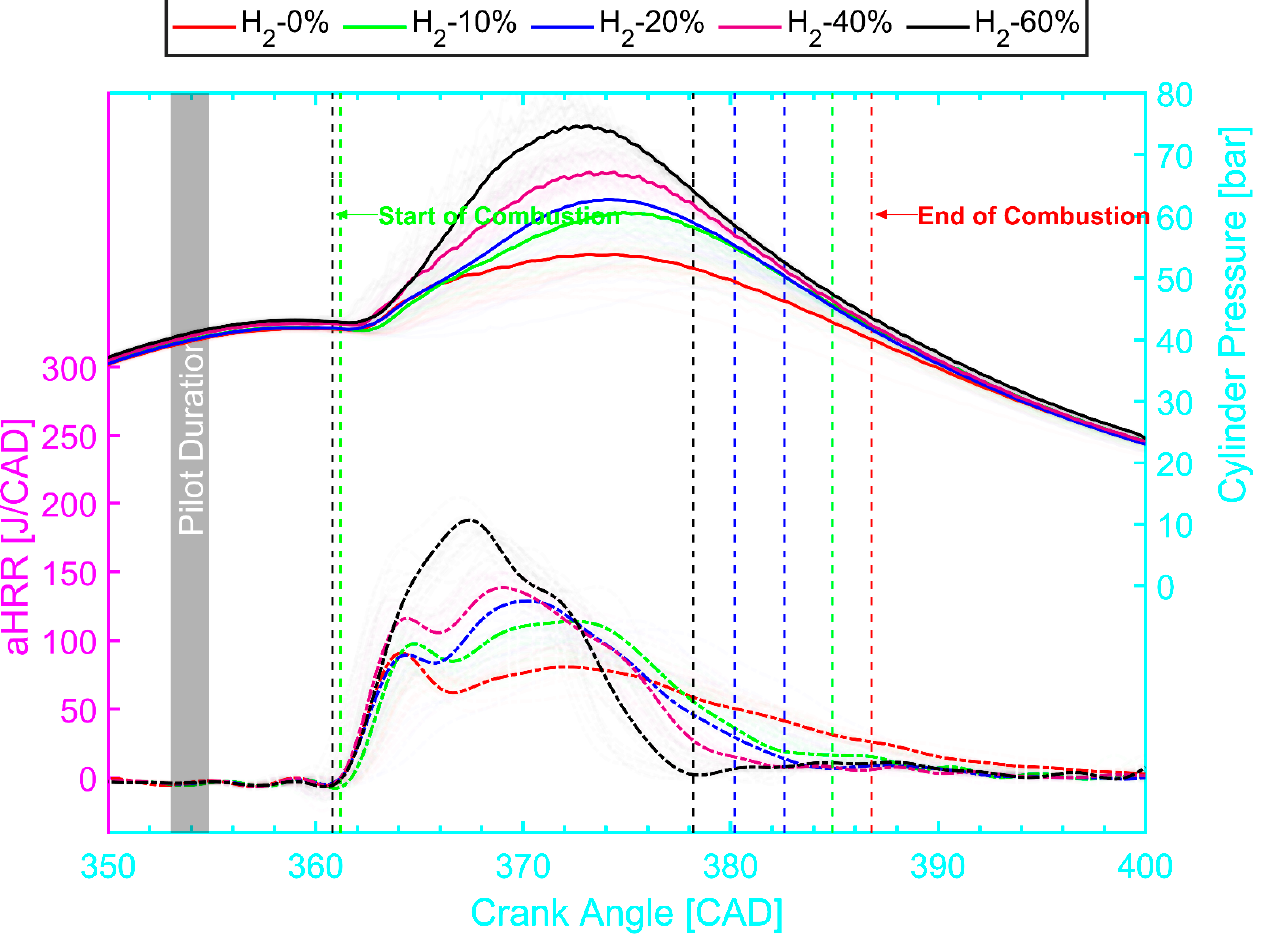
Figure 5. Evolution of cylinder pressure and apparent heat release rate (aHRR) under various H 2 concentrations in the H 2– CH 4 mixture. The pilot injection durations are shown with gray rectangles and the starts of combustions are shown in dashed lines.